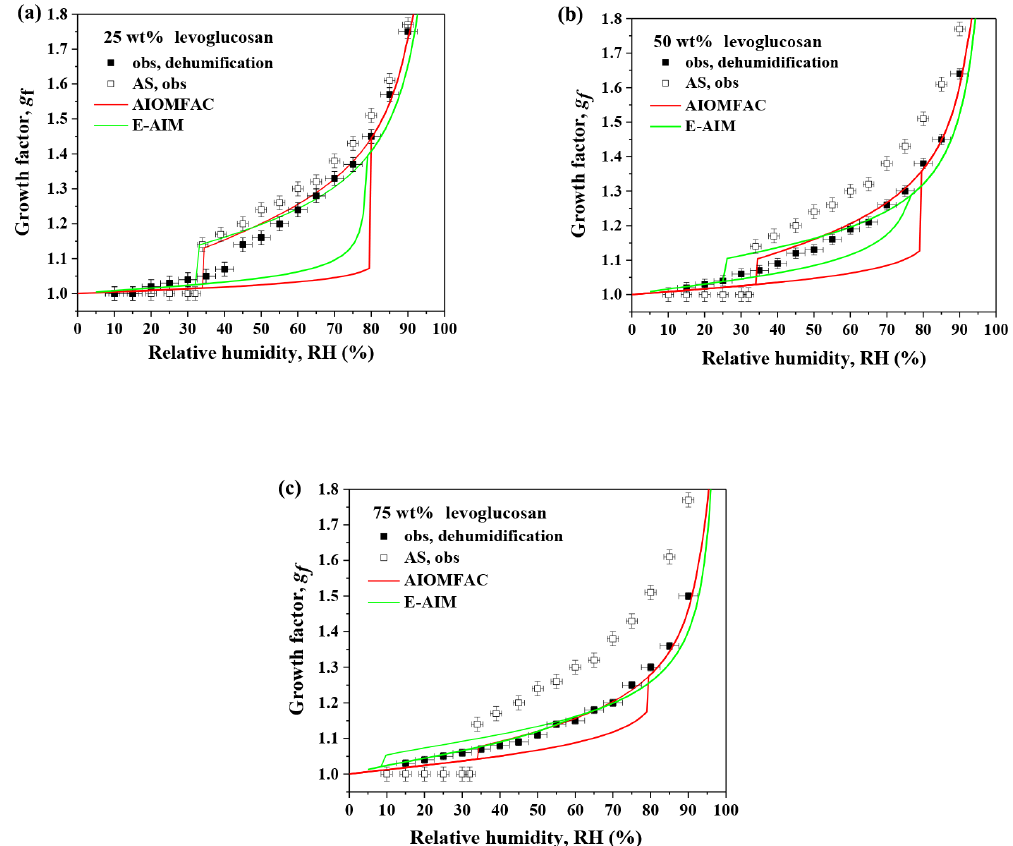
Figure 3. Hygroscopic growth, efflorescence of aerosol particles, and model predictions represent the diameter growth factor during dehydra- tion experiments in the range from 90 to 5% RH at 298.15K (a, b, c) . Hygroscopic growth curves of mixtures consisting of levoglucosan and ammonium sulfate (solid symbols) at three different dry-state mass fractions for particles of an initial dry diameter of 100nm at RH < 5% as compared to that of pure ammonium sulfate (open symbols, “AS, obs”). AIOMFAC-based model predictions for bulk systems are shown in red. E-AIM predictions are shown in